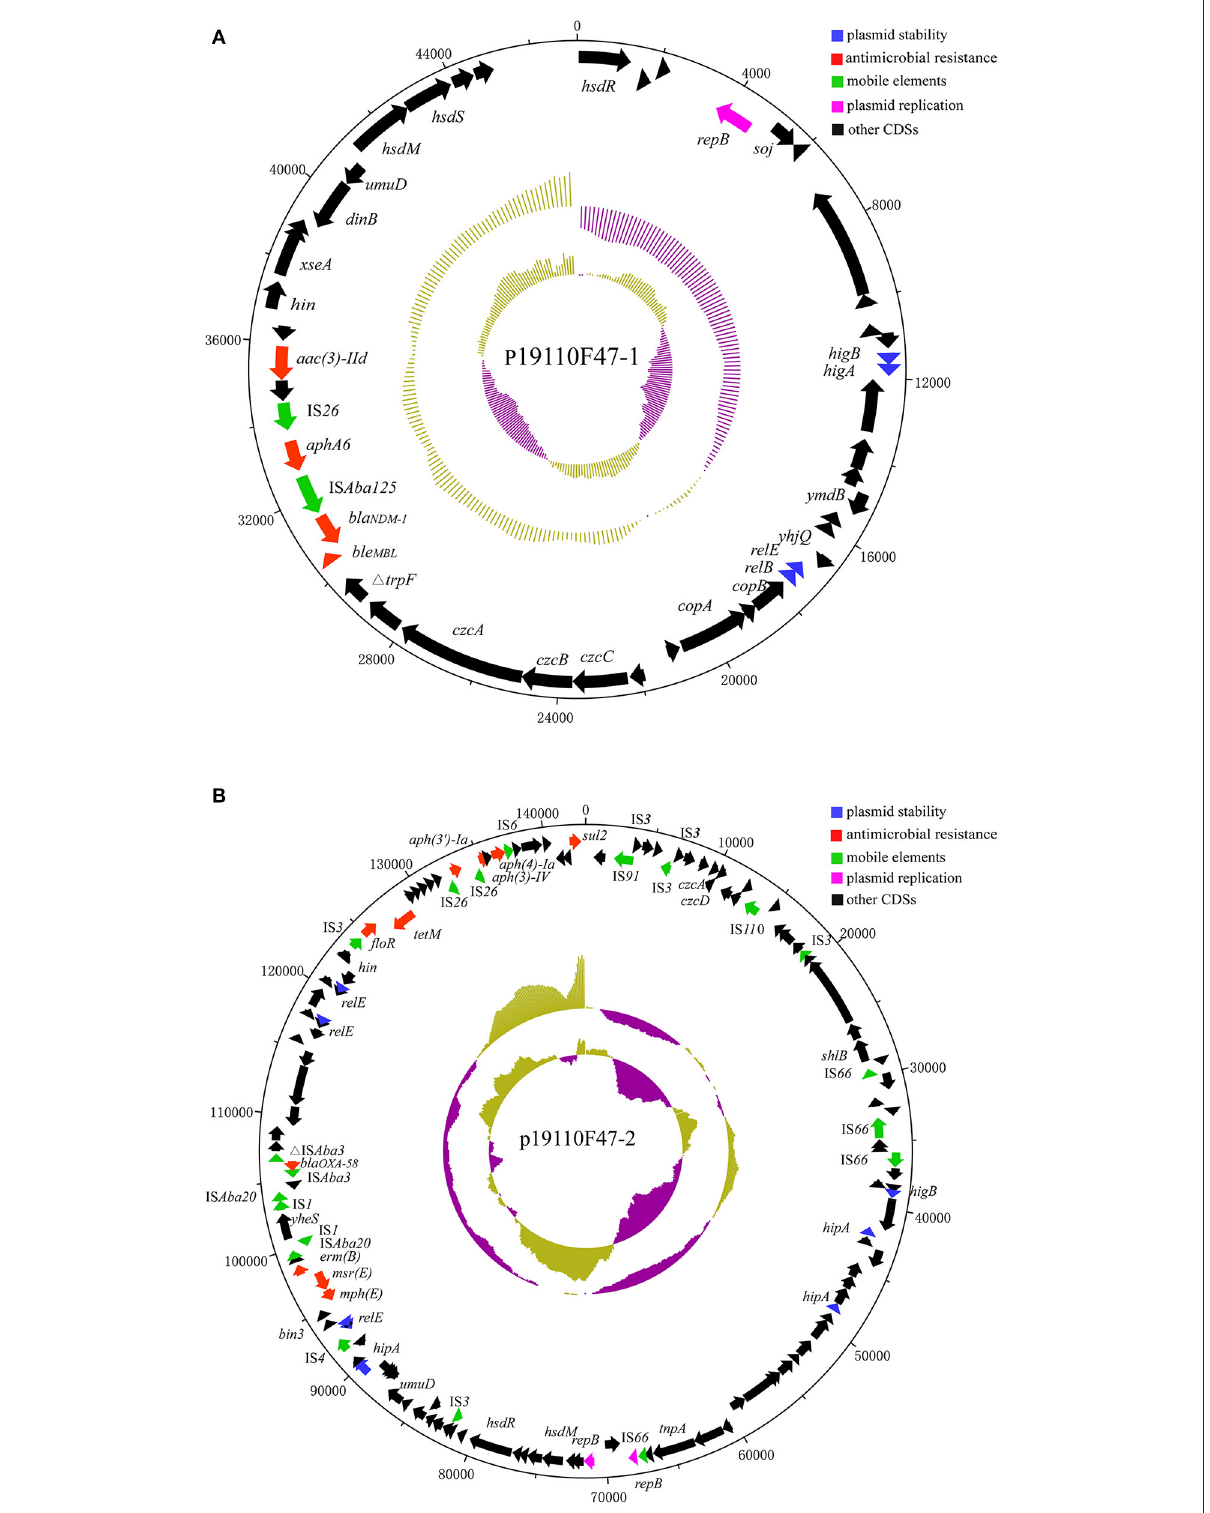
FIGURE2 Structure of plasmids p19110F47-1 (A) and p19110F47-2 (B) from A. towneri 19110F47. The size scales are given in bp; genes are color-coded, depending on functional annotations: red, antimicrobial resistance; blue, plasmid stability; green, mobile elements; purple, plasmid replication; and black, other coding sequences